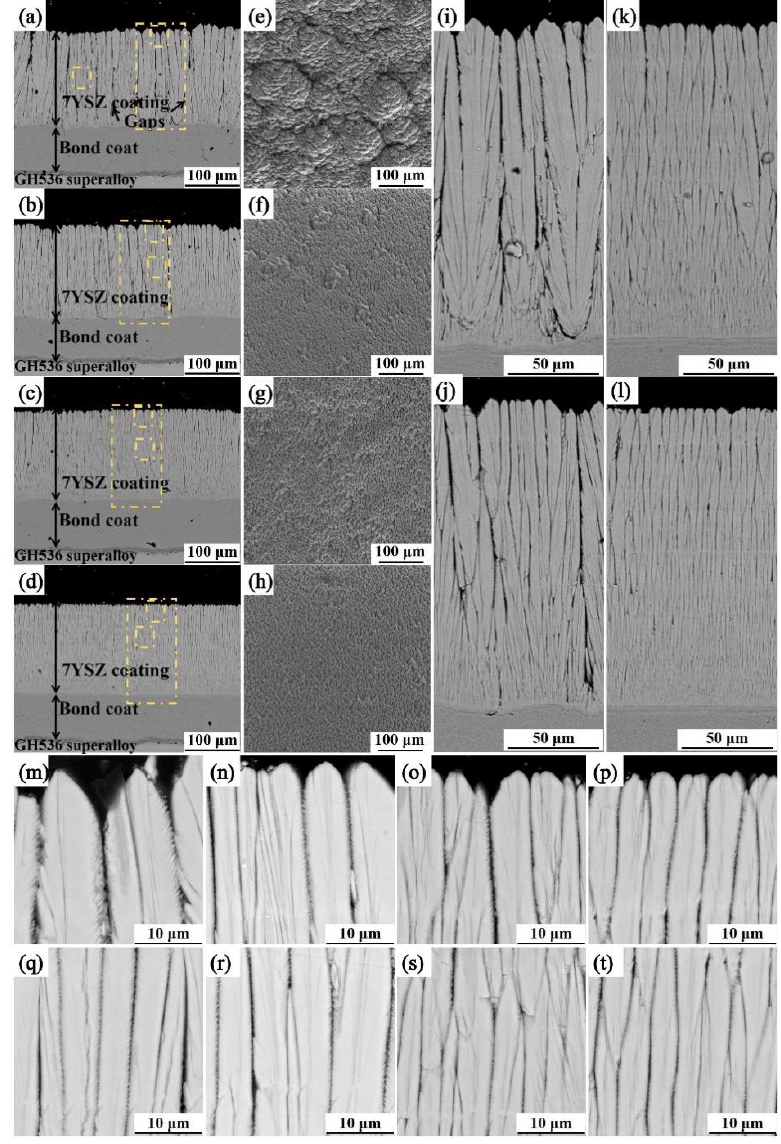
Figure 2. SEM cross-sectional morphologies of the 7YSZ coatings: ( a ) as-prepared sample; ( b ) 100# sample; ( c ) 400# sample; ( d ) 1200# sample. Surface morphologies of the 7YSZ coatings: ( e ) as-prepared sample; ( f ) 100# sample; ( g ) 400# sample; ( h ) 1200# sample; ( i – l ) enlarged coating microstructural morphologies from the selected yellow frame areas of ( a – d ); ( m – p ) enlarged coating microstructural morphologies near the surface from the selected yellow frame areas of ( a – d ); ( q – t ) enlarged coating microstructural morphologies halfway through the thickness from the selected yellow frame areas of ( a – d ).